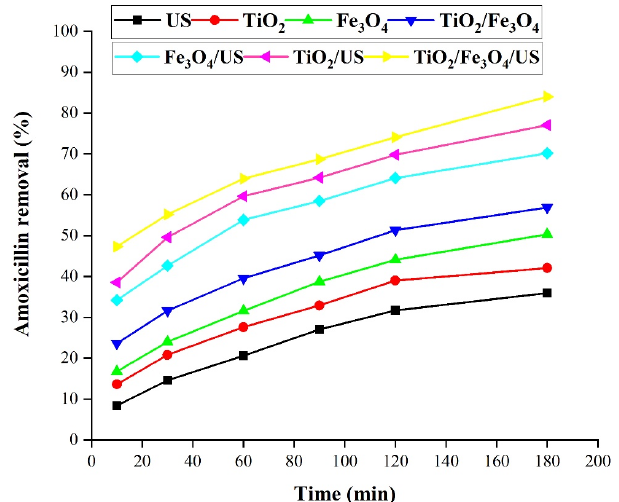
Fig. 5. Comparison of processes performed in the removal of amoxicillin under optimal